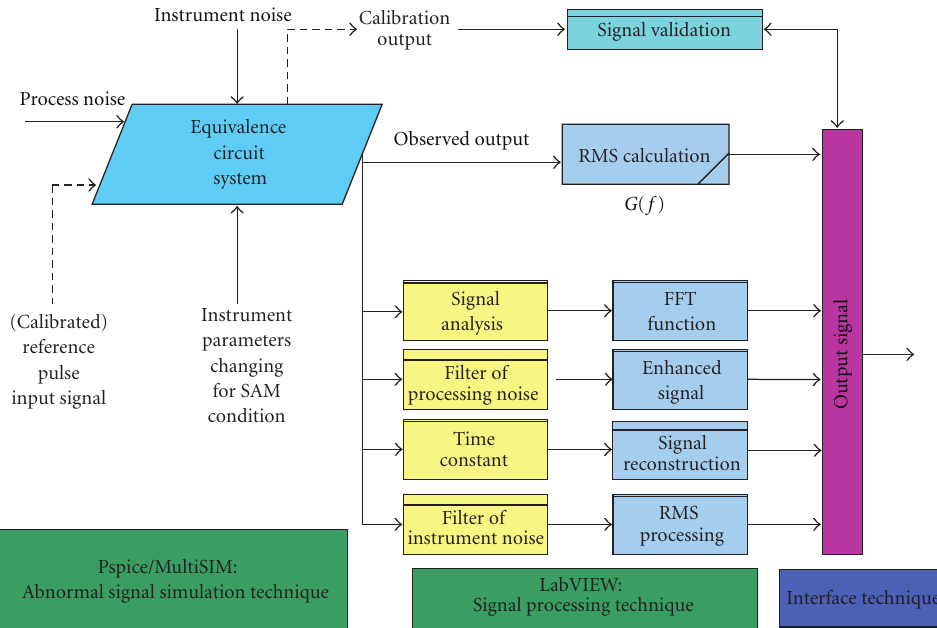
Figure 8: Block diagram for the signal processing and analysis from ASSA module system.